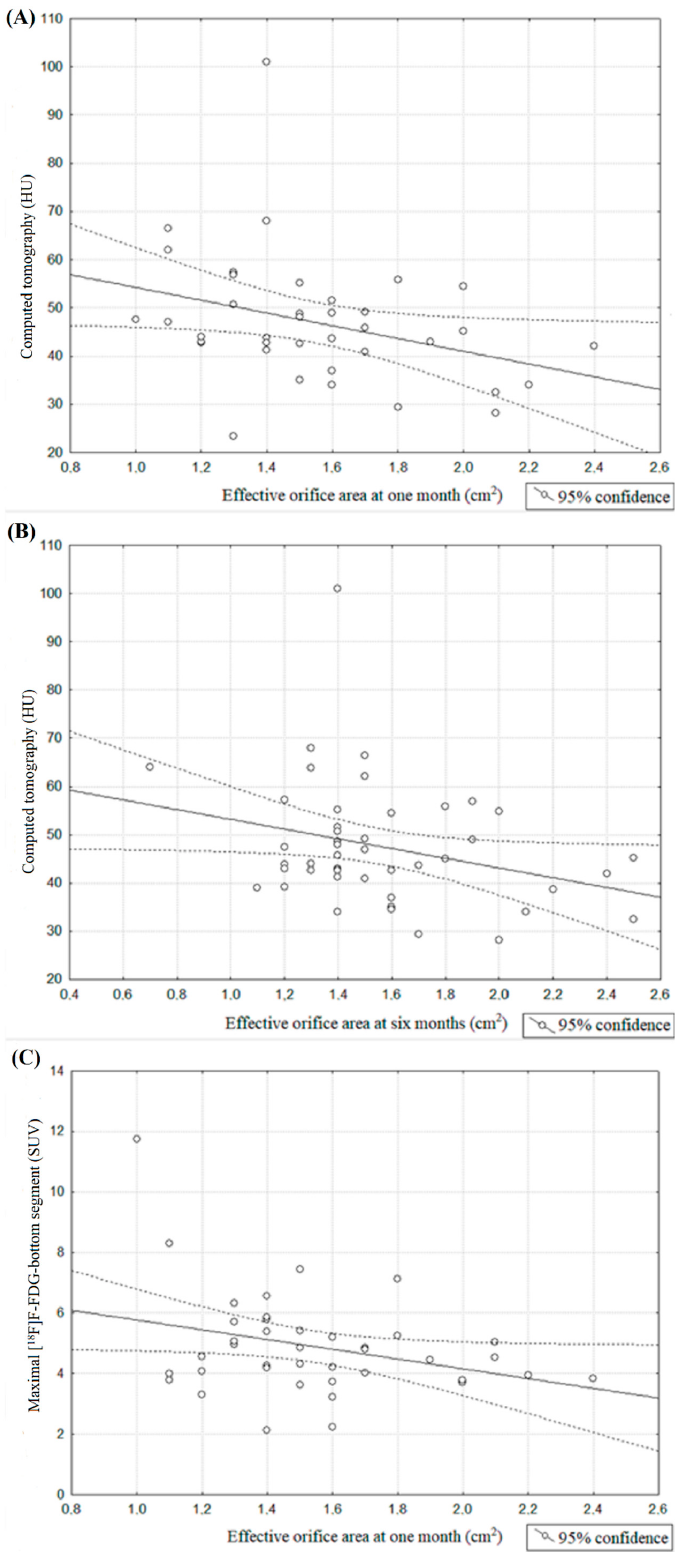
Figure 4. ( A ) Spearman’s correlation coefficient between effective orifice area at 1 month and [ 18 F]F-fluorodeoxyglucose (HU) assessed at 6 month; ( B ) Spearman’s correlation coefficient be- tween effective orifice area at 6 months and [ 18 F]F-fluorodeoxyglucose (HU) assessed at 6 month; ( C ) Spearman’s correlation coefficient between effective orifice area at 1 month and maximal [ 18 F]F- fluorodeoxyglucose assessed for bottom segment assessed at 6 months of FU